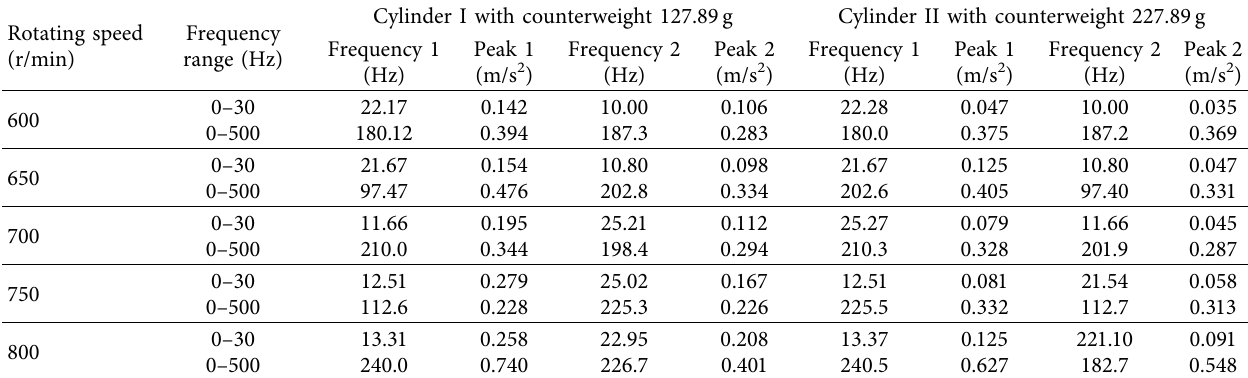
Table 5: FFTmain data of vibration acceleration of three-cylinder bilateral drive cylinder I in the horizontal position of the bearing seat in the Y